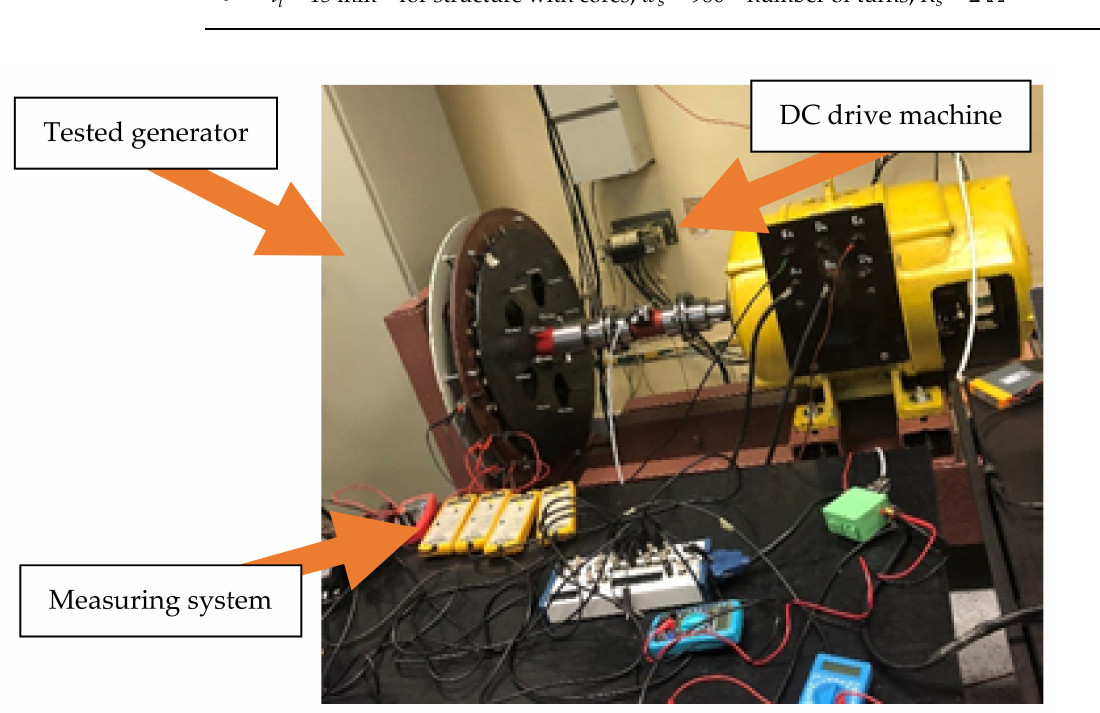
Figure 4. Laboratory test